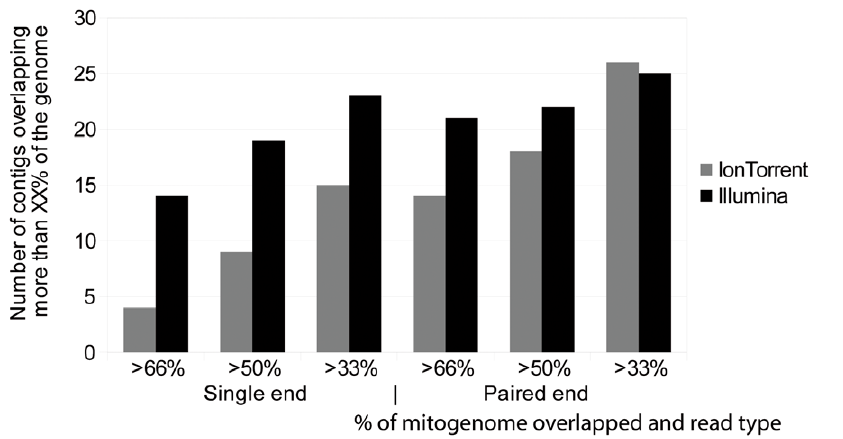
Figure 6. Comparison of paired-end and single sequences for two platforms (Illumina MiSeq vs. Ion Torrent PGM) and 30 mitogenomes. Number of contigs overlapping more than X% against number of mitogenomes. Overlap % calculated against an average mitogenome size (16400 bp).